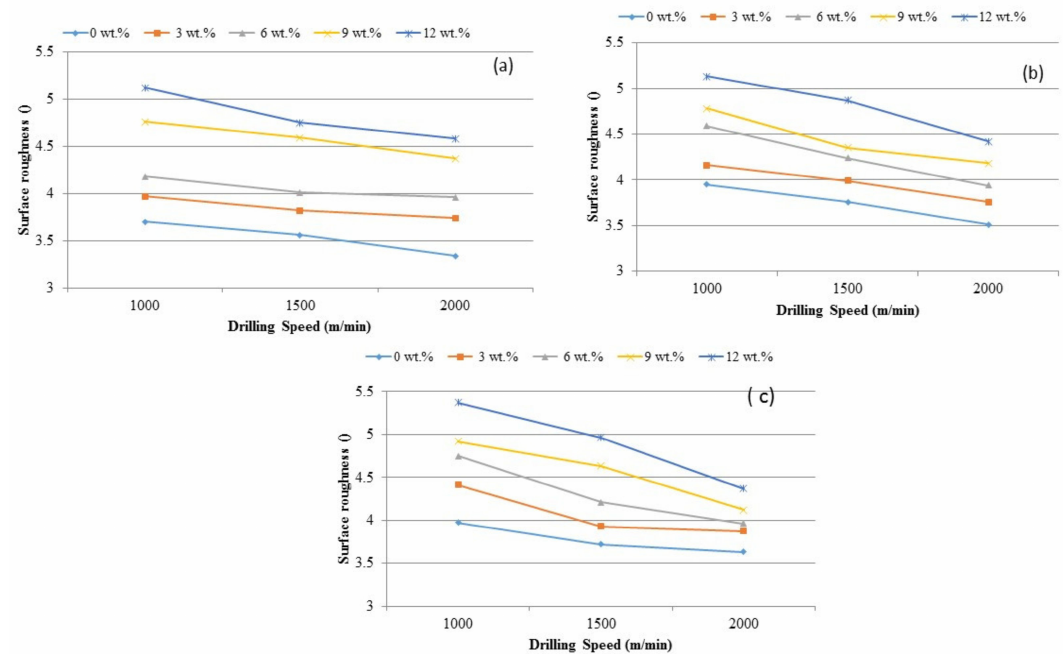
Figure 8. The influence of TiB 2 on cutting force under various surface roughness and feed rate levels ( a ) 0.5 mm/rev, ( b ) 1.0 mm/rev and ( c ) 1.5 mm/rev.